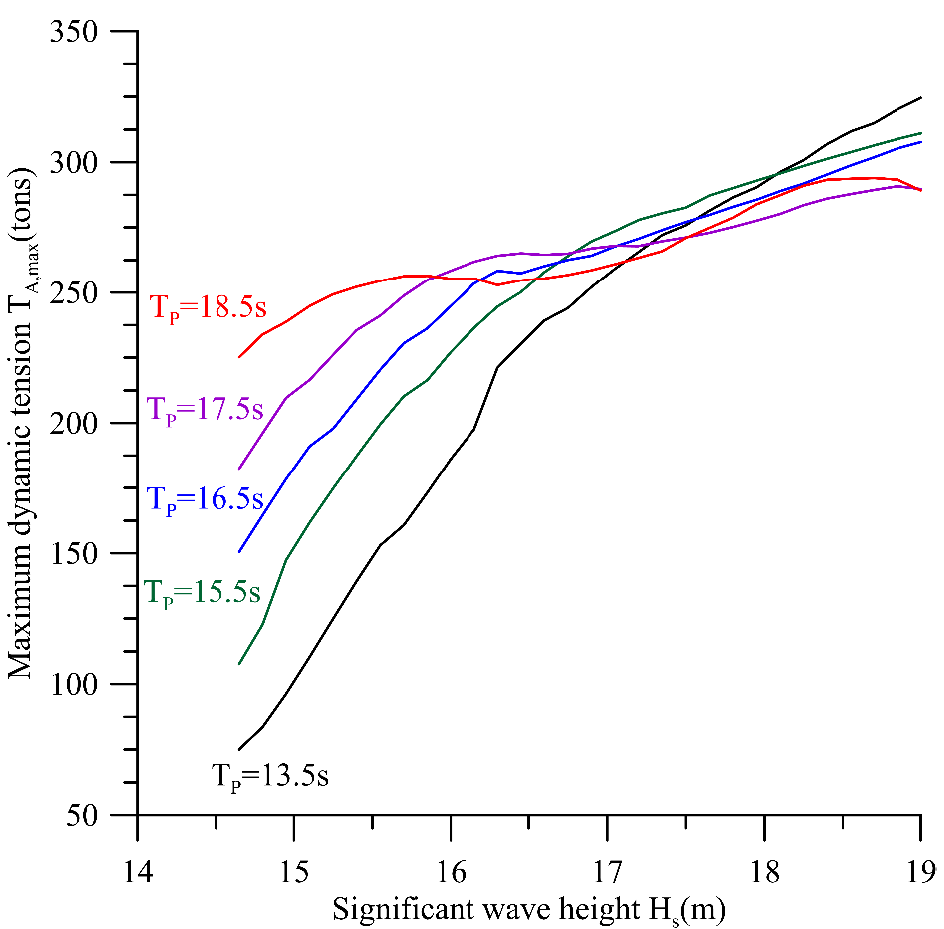
Figure 14. Dynamic tension T A,max under the typhoon irregular wave as a function of the significant wave height H s and the peak period T p .